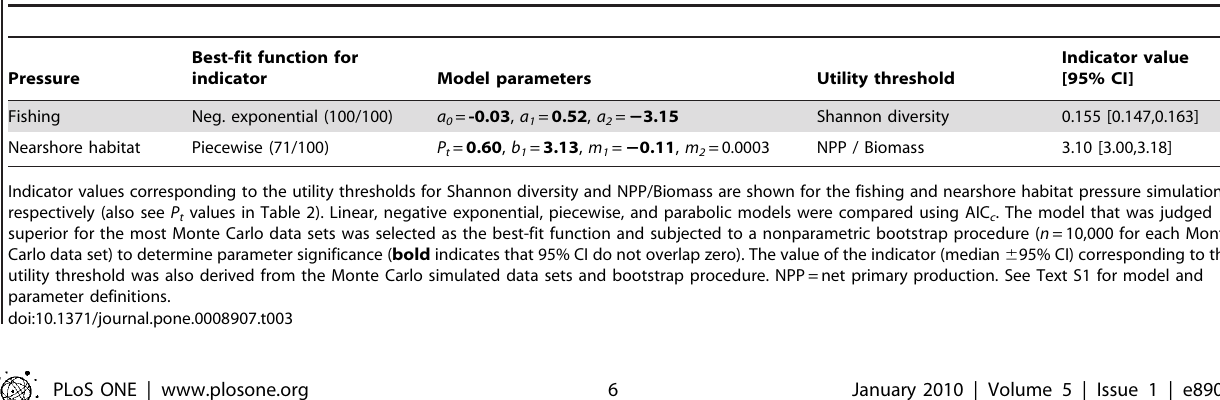
Table 3. Best-fit models and parameters for indicator–pressure relationships generated through fishing ( n =15) and nearshore habitat pressure ( n = 14) Monte Carlo simulations ( n =100 at each pressure